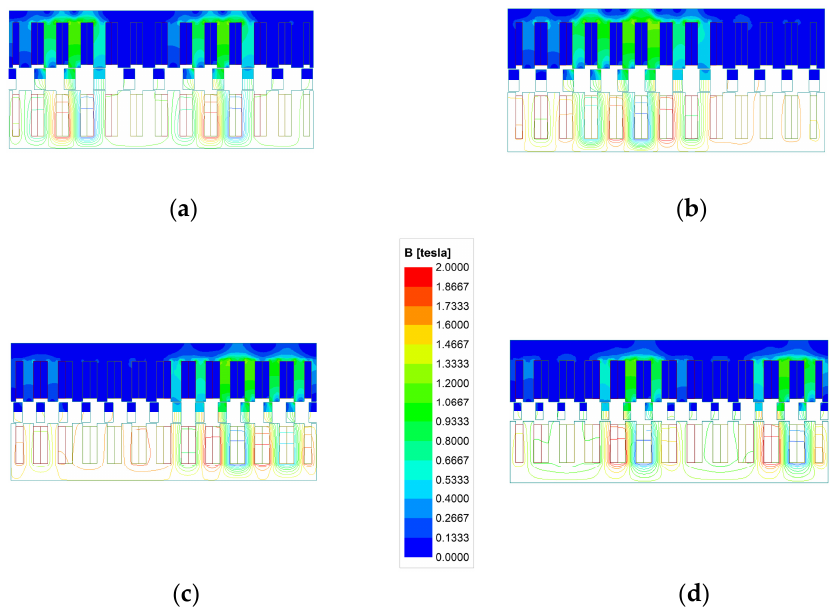
Figure 12. The magnetic flux density distribution of DCB-VRLMs with different combinations of P a / N sp / P dc . ( a ) Model 1: 4/10/6. ( b ) Model 2: 5/11/6. ( c ) Model 3: 7/13/6. ( d ) Model 4: